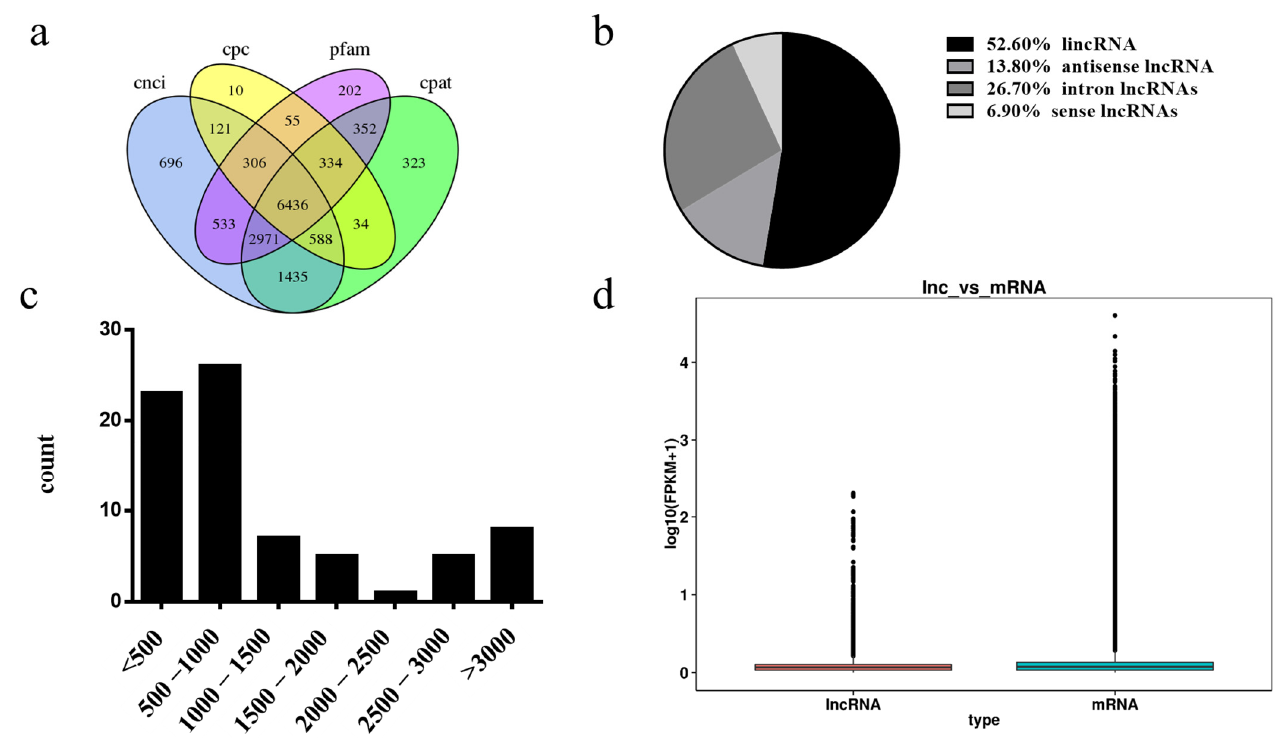
Figure 3. Analysis of lncRNAs. ( a ) Cross-analysis of CNC, CPC, Pfam, and CPAT data revealing lncRNAs. ( b ) Classification of 6436 lncRNAs, including lincRNAs, antisense lncRNAs, intronic lncRNAs, and sense lncRNAs. ( c ) Distributions of the sequence length of lncRNAs. ( d ) Boxplots of the expression levels (log10(FPKM)) of lncRNAs and protein-coding genes.